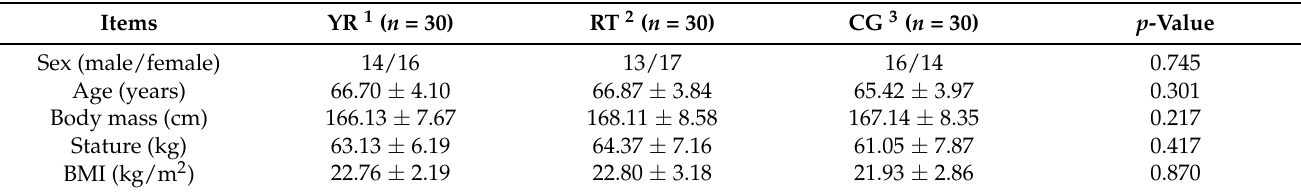
Table 1. Results of demographic characteristics of the participants at baseline.